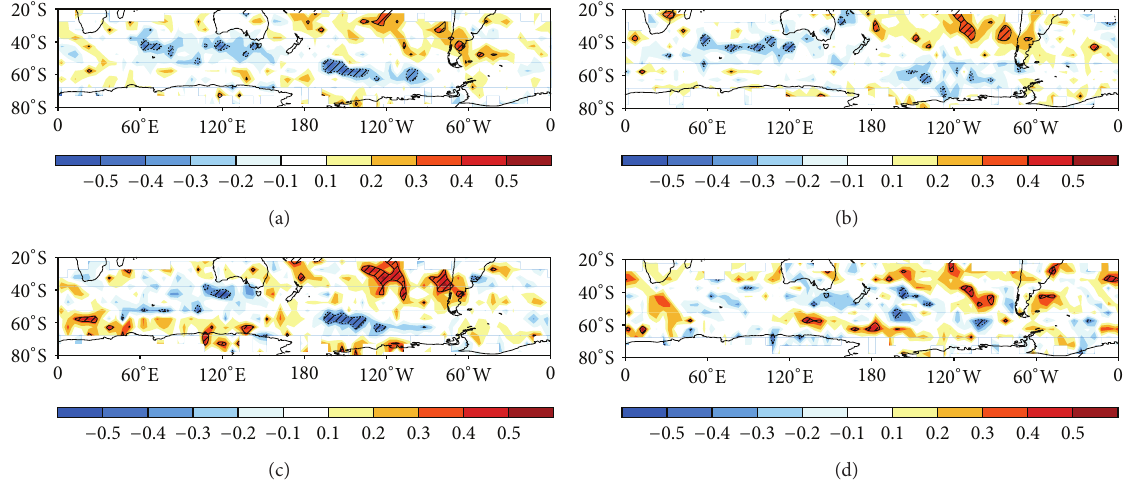
Figure 6: Partial correlation coefficient for cyclone frequency versus ENSO (excluding IOD) for SH Winter (JAS). Correlation (shaded), 2-Tail 90% significance (hatched) for (a) NCEP1 5801, (b) ERA40 5801, (c) NCEP1 7910, and (d) NCEP1 5078.